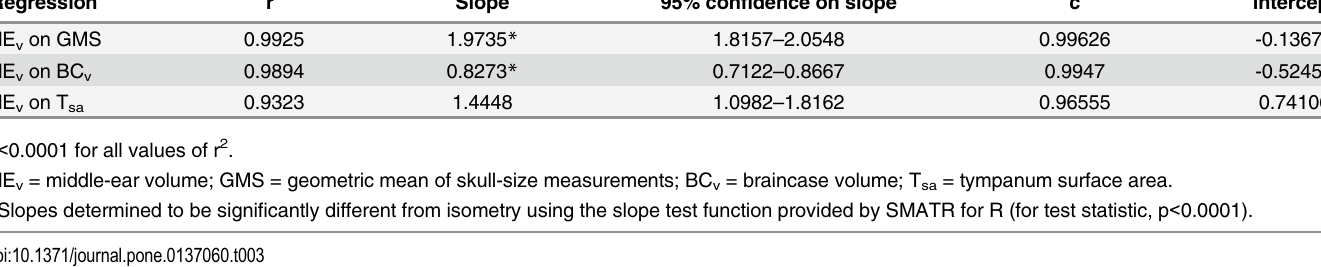
Table 3. Comparisions of reduced major axis (RMA) regressions for middle-ear volume.